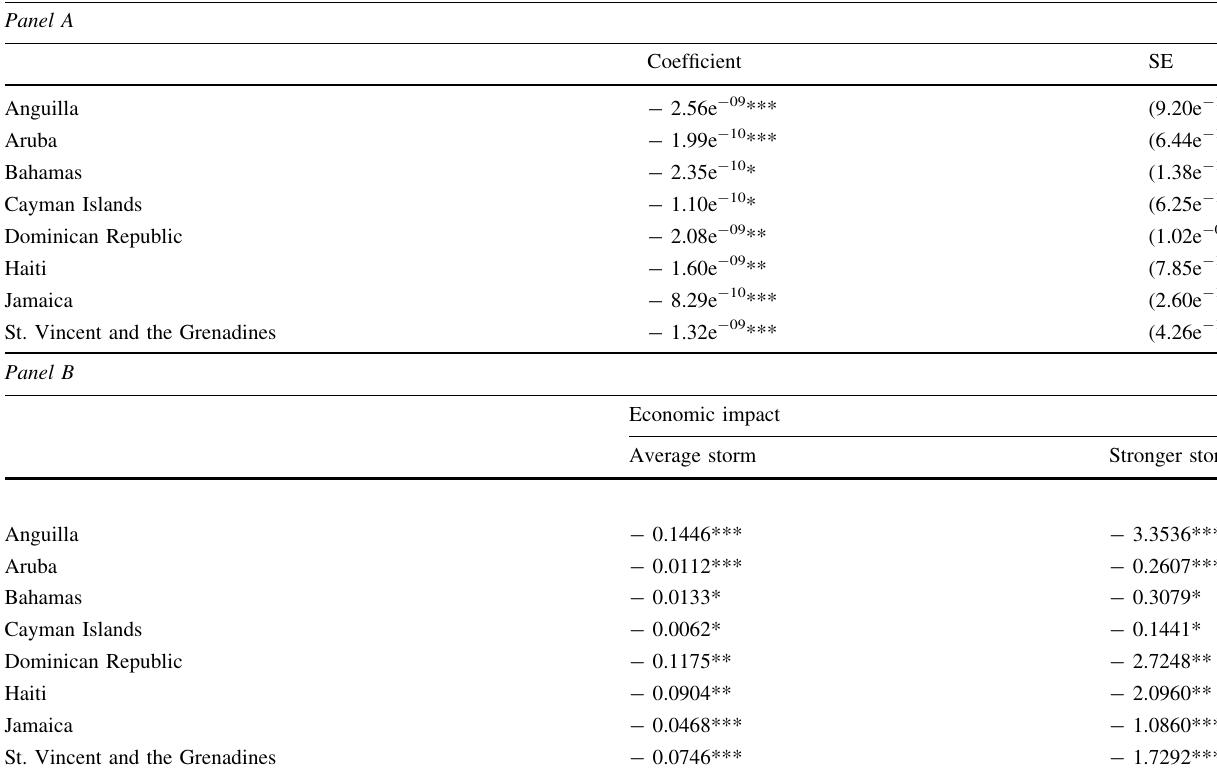
Table 6 Impact of hurricanes on production efficiency by geography in the Caribbean Panel